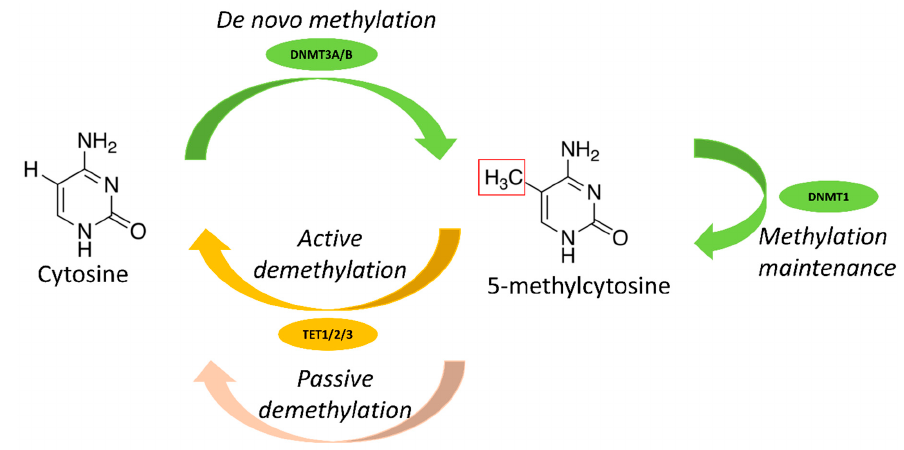
Figure 1. Main enzymes involved in DNA methylation.